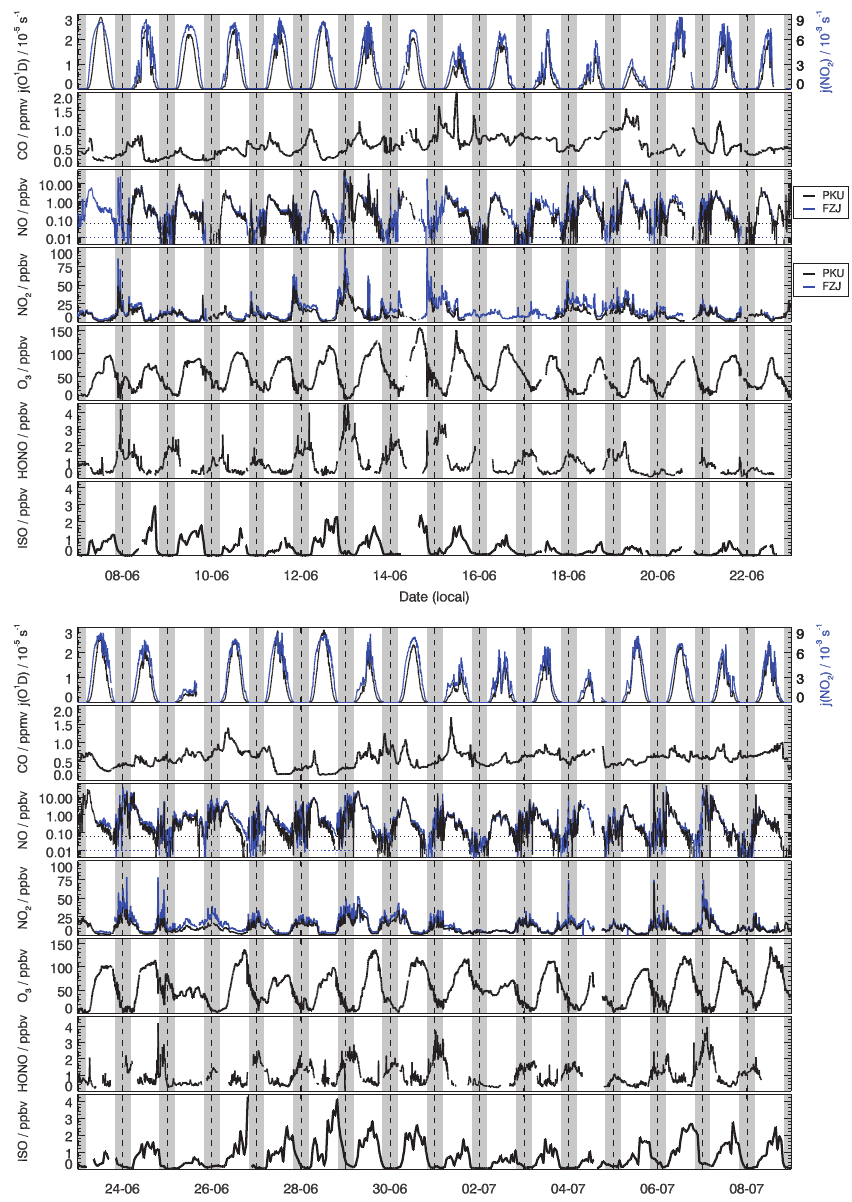
Figure 3. Time series (5min data) of measurements during this campaign for j ( O 1 D ) , j ( NO 2 ) , CO, NO, NO 2 , HONO, O 3 and isoprene (ISO) used as constraints for model calculations. Vertical dashed lines denote midnight. Grey areas indicate nighttime. Several species were measured by two instruments provided by PKU and FZJ. Measurements of both instruments for O 3 and CO agreed well, so that data sets were combined to close data gaps. Only the combined data set is shown here, but different colors indicate the origin of data. NO 2 and NO mixing ratios measured by the PKU instruments were generally 20% smaller than those measured by the FZJ instrument. The horizontal lines denote the limit of detection for two NO instruments (10pptv for FZJ; 60pptv for PKU). Both time series are shown, but measurements from the PKU instruments were used as model